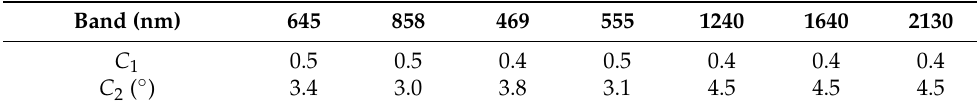
Table 2. The best C 1 and C 2 for MODIS in seven common